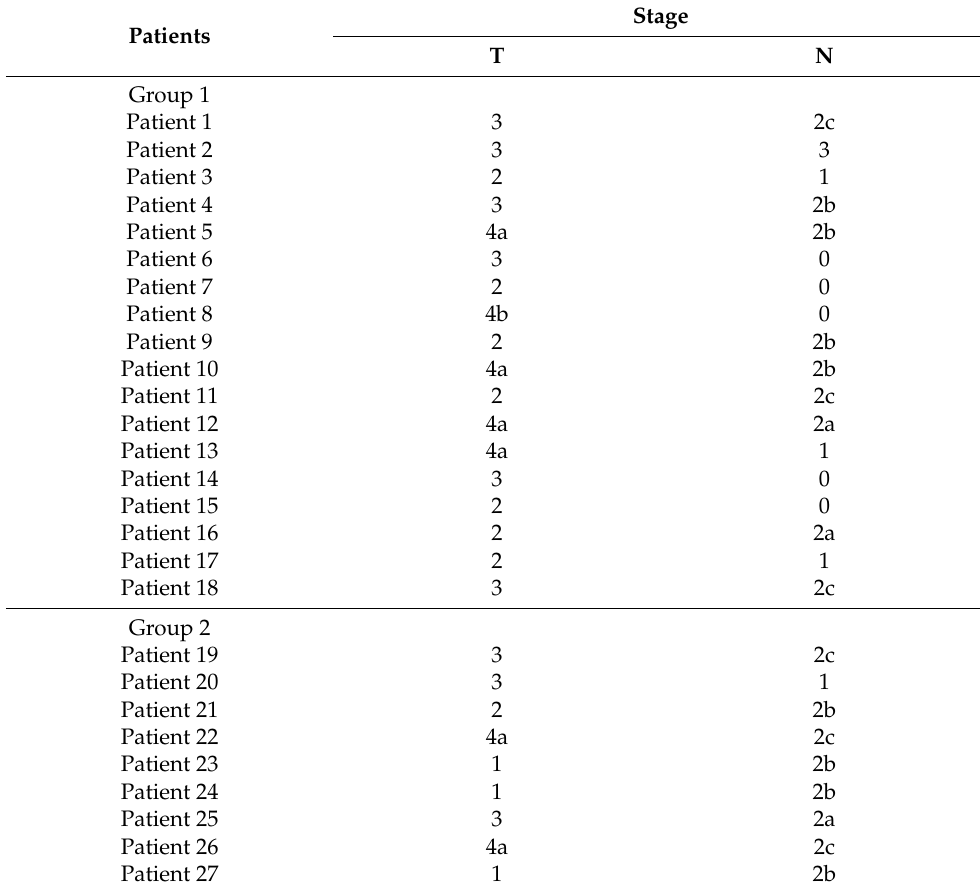
Table 1. T and N stages at baseline for the patients with mild xerostomia (Group 1) and moderate xerostomia (Group